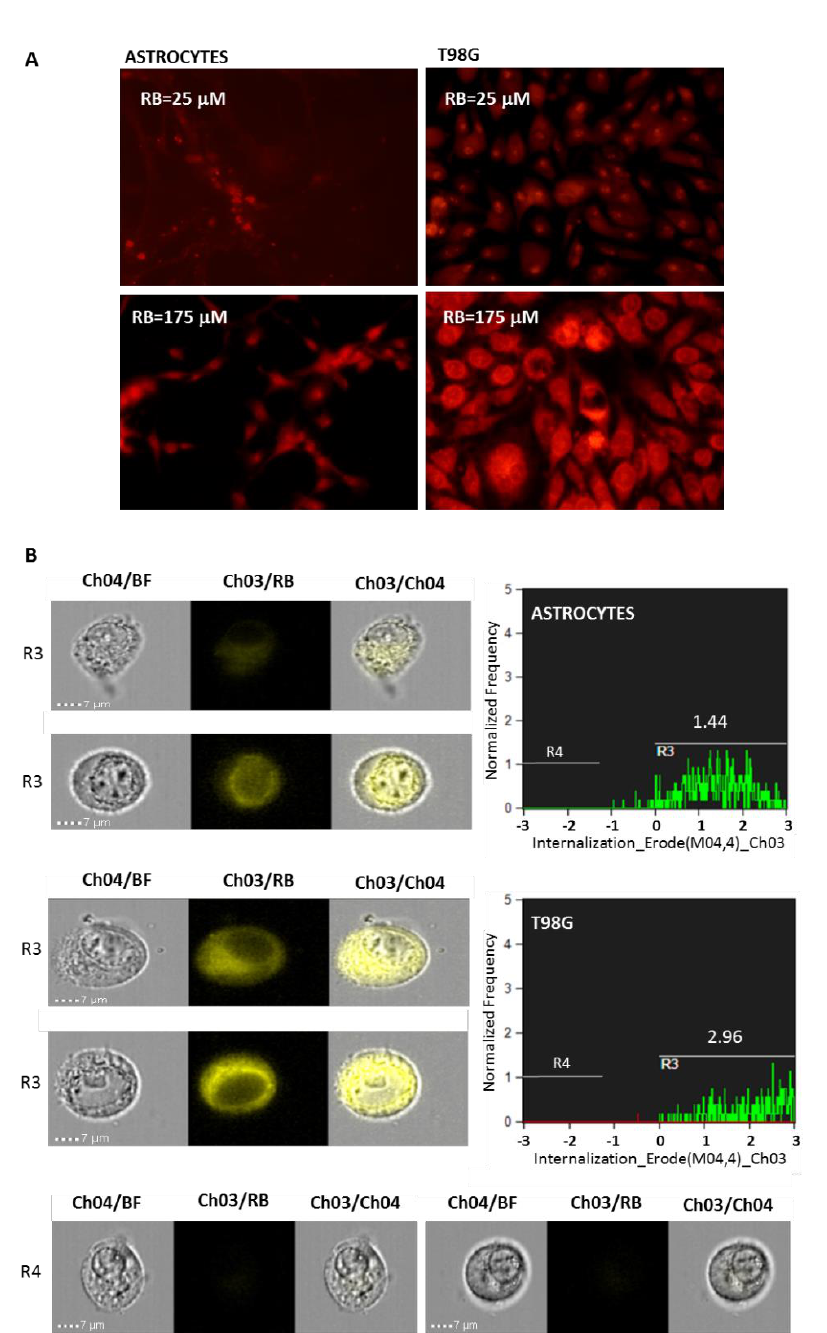
Figure 2. RB internalization analysis in normal rat astrocytes and in T98G astrocytoma cells. ( A ) Cells were incubated with RB (25 or 175 μM for 24 h) and visualized using a Nikon Eclipse TS100 inverted florescence microscope at 20× magnification (G2A blocking filter; exc. = 535/50 nm; dichr. mirr. = 577 nm; barrier = 580 nm). ( B ) Amnis ImageStream flow cytometry analysis of RB (25 μM) internalization in normal rat astrocytes and in T98G cells analyzed after 24 h p.t. Trypsinized cells were analyzed for bright field (Ch04) and for RB fluorescence (Ch03) at 60× magnification. Percentages of focused cells ( n = 10,000) with RB internalization spots and Internalization Erode median parameters are reported. RB internalization was analyzed by the “Internalization” wizard with the following gating strategy: single cells were gated (using Area/Aspect Ratio Intensity, R1, not shown); R1 was then gated for focused cells using the “Gradient-RMS” feature (R2 gate, not shown), and finally, Ch3 intensity was measured with “Internalization” feature and an “Erode” mask applied (gates R3 and R4). Examples of cell images of R3 and R4 gates are shown.